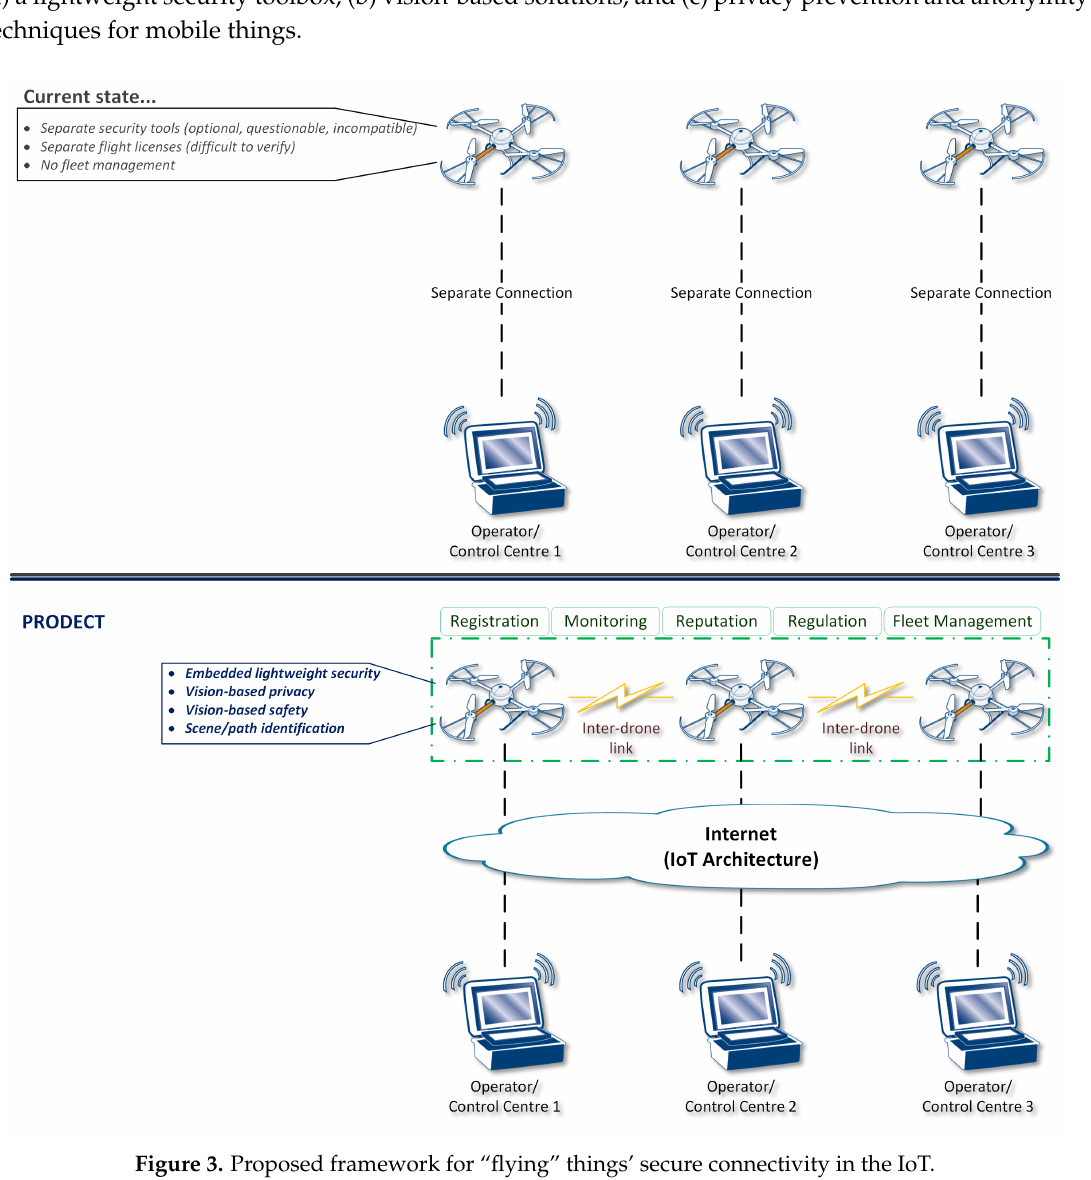
Figure 3. Proposed framework for “flying” things’ secure connectivity in the